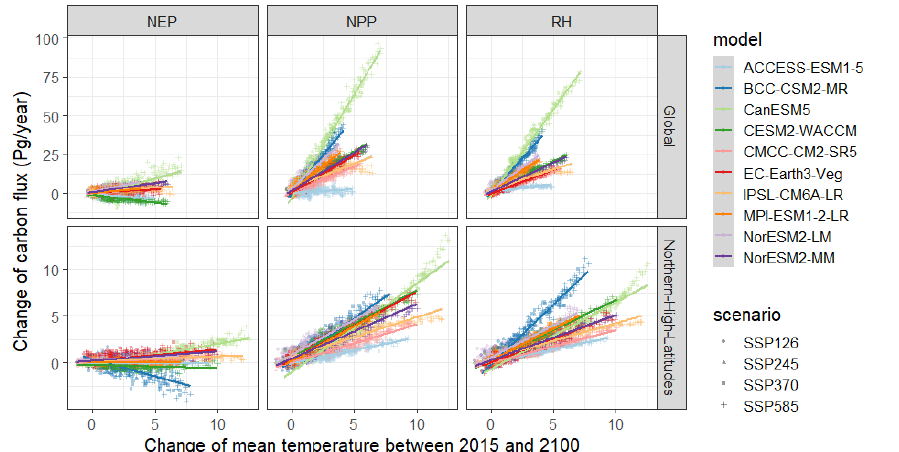
Figure 2. Sensitivity of carbon flux changes in response to the TAS changes (relative to the 2015 values) at global and NHL scales for each CMIP6 model under the four future scenarios.